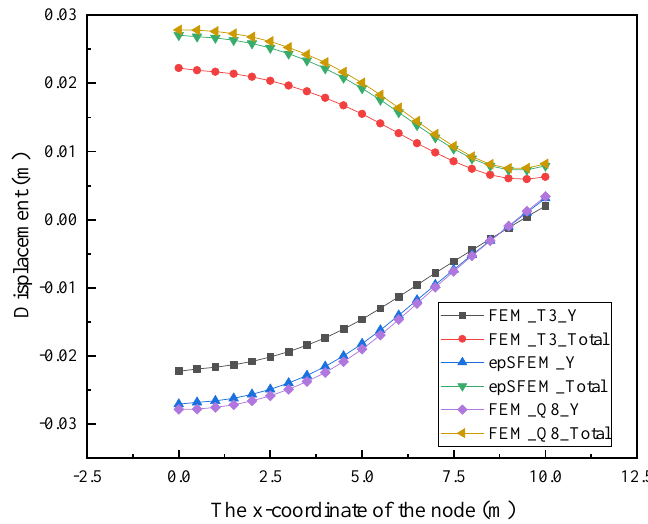
Figure 9. Comparison curves of node displacements at the top of the model calculated by differ- ent methods.